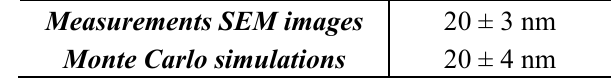
Table 2. Average diameters of MWCNTs covered by a cytochrome P4503A4 monolayer, obtained by measurements on SEM images and Monte Carlo